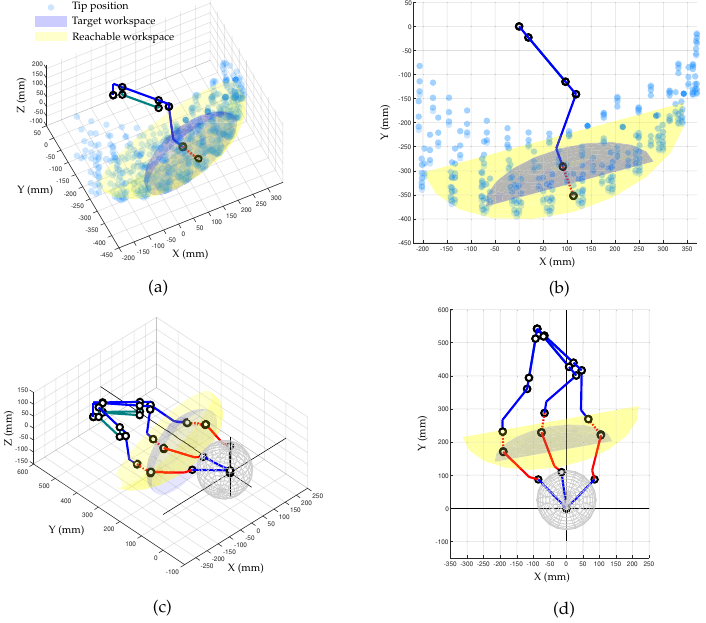
Figure 11. Reachable workspace computed via numerical simulation: ( a ) perpendicular view of the reachable workspace by the translational motion structure; ( b ) top view of the reachable workspace by the translational motion structure; ( c ) perpendicular view of the reachable workspace by the entire motion-tracking system; ( d ) top view of the reachable workspace by the entire motion-tracking